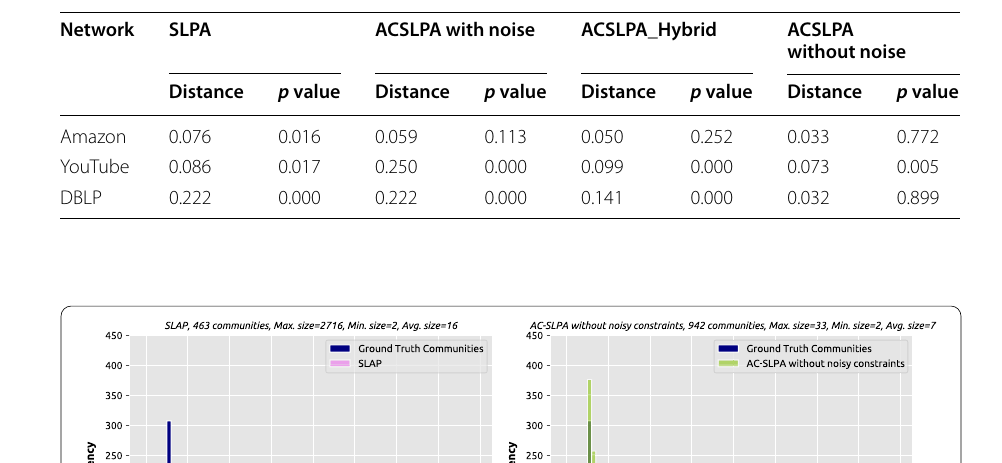
Table 21 Kolmogorov-Smirnov distance between the community size distribution of the obtained results of SLPA, ACSLPA with and without noisy constraints, and ACSLPA_ Hybrid on real-world networks against the community size distribution of the ground truth communities